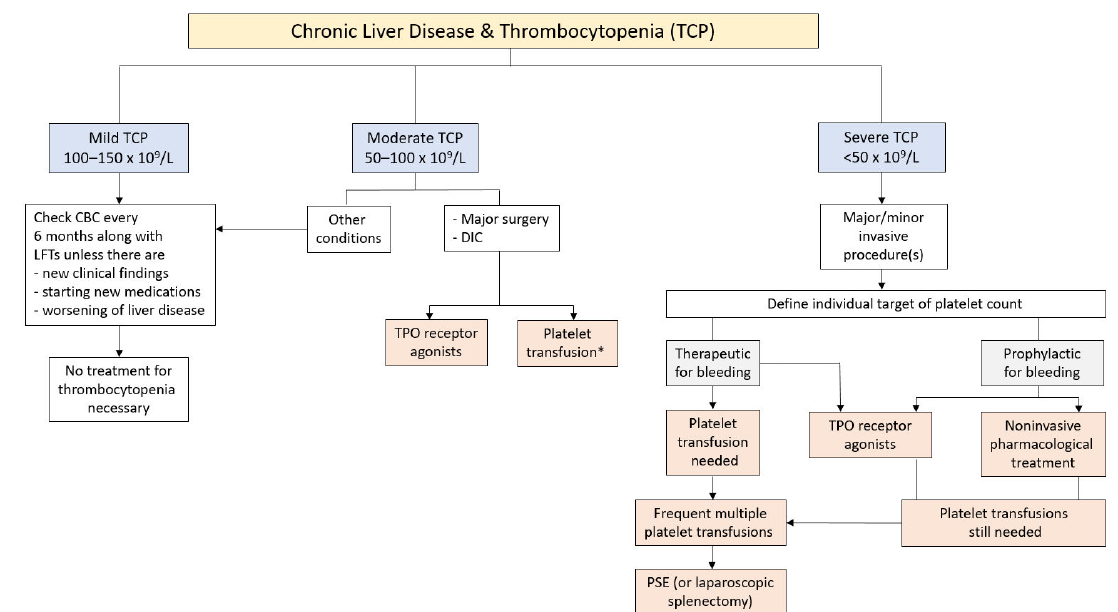
Figure 2. Proposed management of mild, moderate, and severe thrombocytopenia in patients with chronic liver disease. Displayed is the compilation of a treatment algorithm, originally designed by Gangireddy et al. [85] and subsequently adapted by Saab and Brown [25]. In this modification, administration of plasma products (e.g., fibrinogen concentrate, activated factor VII, prothrombin complex concentrate) as rescue therapy for active bleeding is omitted for clarity. To confirm no need for treatment, patients with mild thrombocytopenia should have periodic re-examination including complete blood screening. Of note, for moderate and severe thrombocytopenia, the use of TPO receptor agonists is now considered as first-choice treatment option, whereas platelet transfusions are restricted to major surgery and control of active hemorrhage. The star indicates that, upon platelet transfusion, a target platelet count >100,000/ µ L is aimed at. Abbreviations: CBC, complete blood cell count; DIC, disseminated intravascular coagulation; LFT, liver function testing; PSE, partial splenic embolization; TCP, thrombocytopenia; TPO,